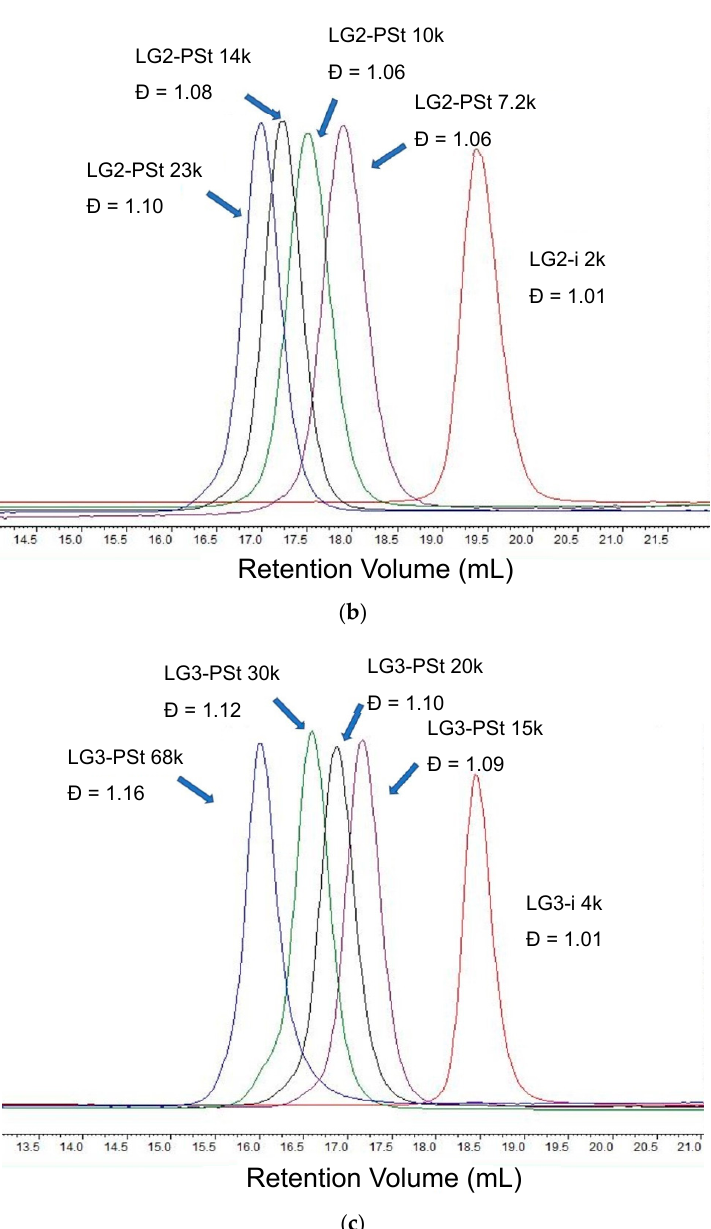
Figure 2. ( a ) SEC traces of LG1-PSt copolymers with different lengths of the PSt block, SEC traces of LG2-PSt ( b ), and LG3-PSt ( c ) LDBCs with different lengths of the PSt block .